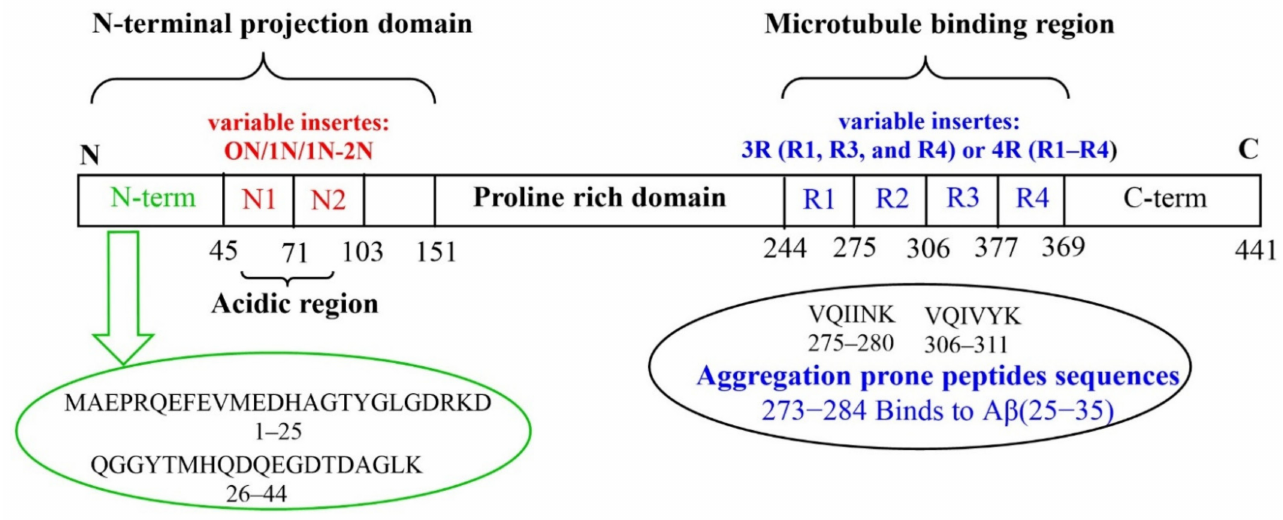
Figure 1. Tau protein: longest tau isoform (441 amino acids) containing the variable inserts (N1, N2, R1, R2, R3 and